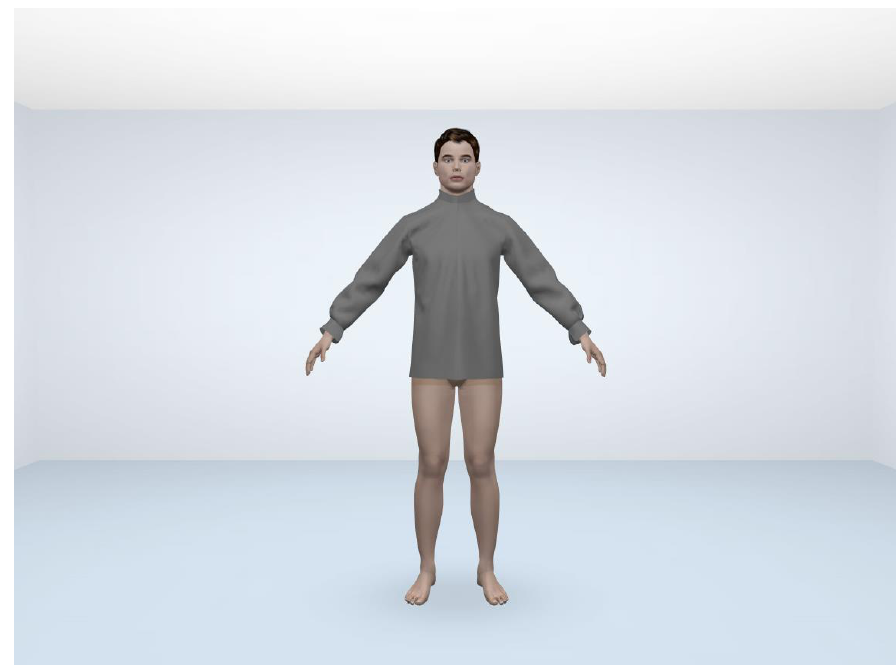
Figure 13. Shirt after